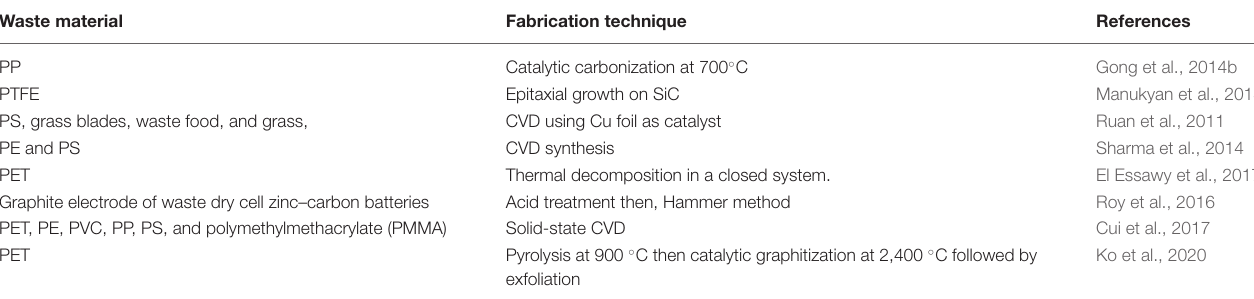
TABLE 5 | Synthesis of graphene from waste